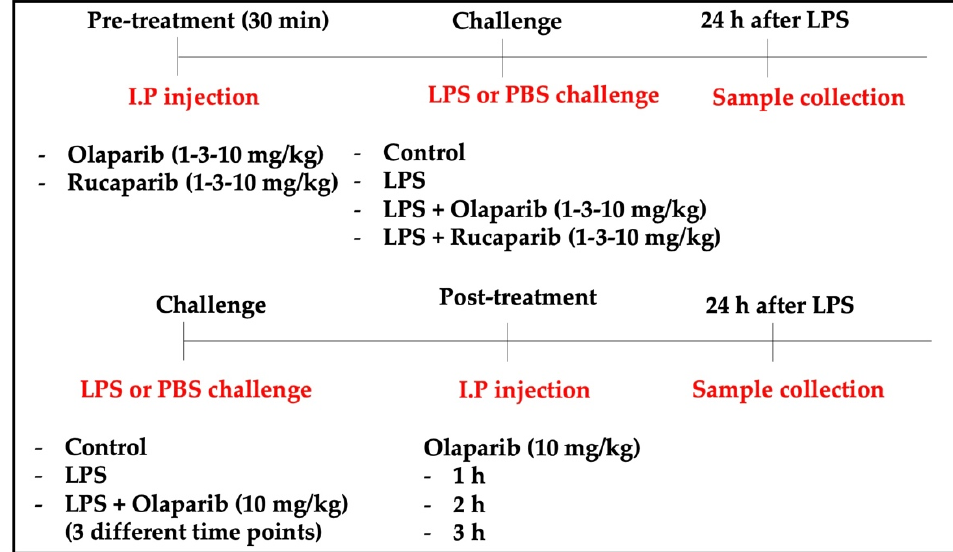
Figure 1. Experimental design used for the in vivo